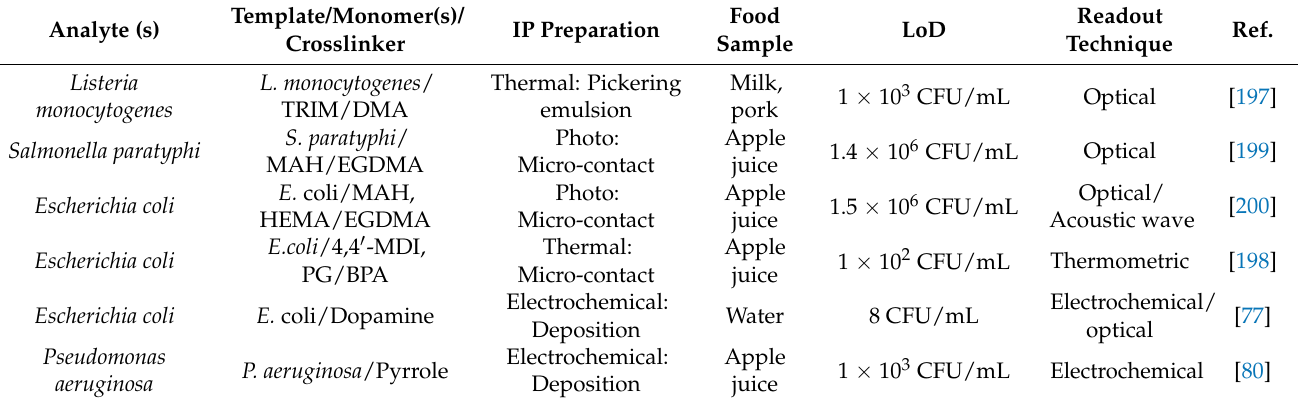
Table 5. Summary of recent publications for the recognition of bacteria using IPs in food samples. Analyte (s)